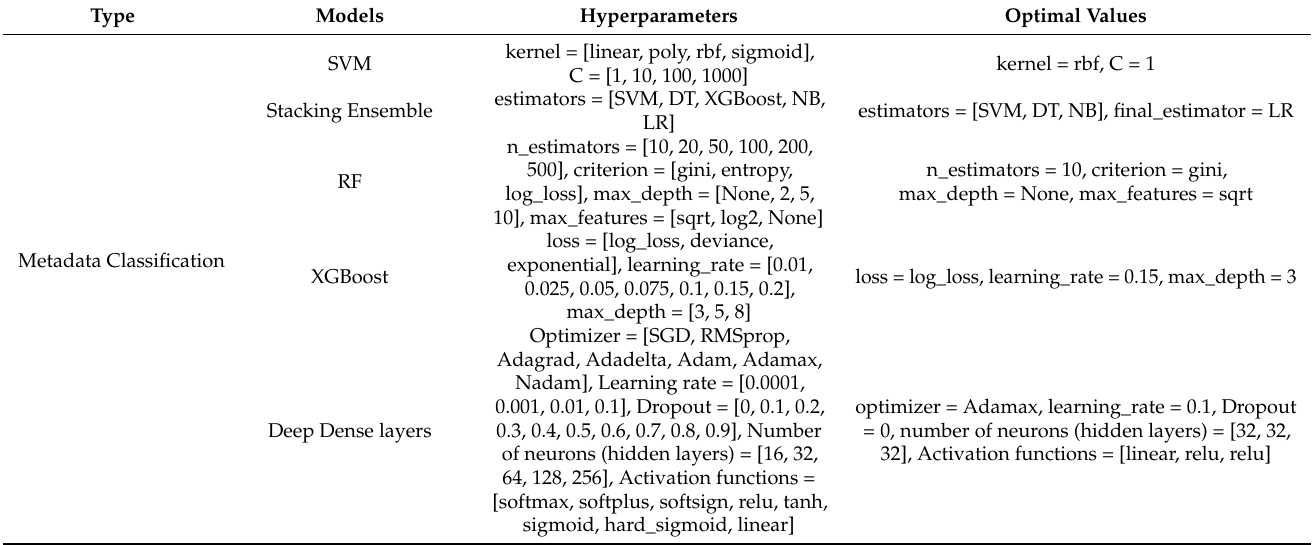
Table A1. The hyperparameters used in the ML and DL models in the classification module and their optimal value obtained from the grid search